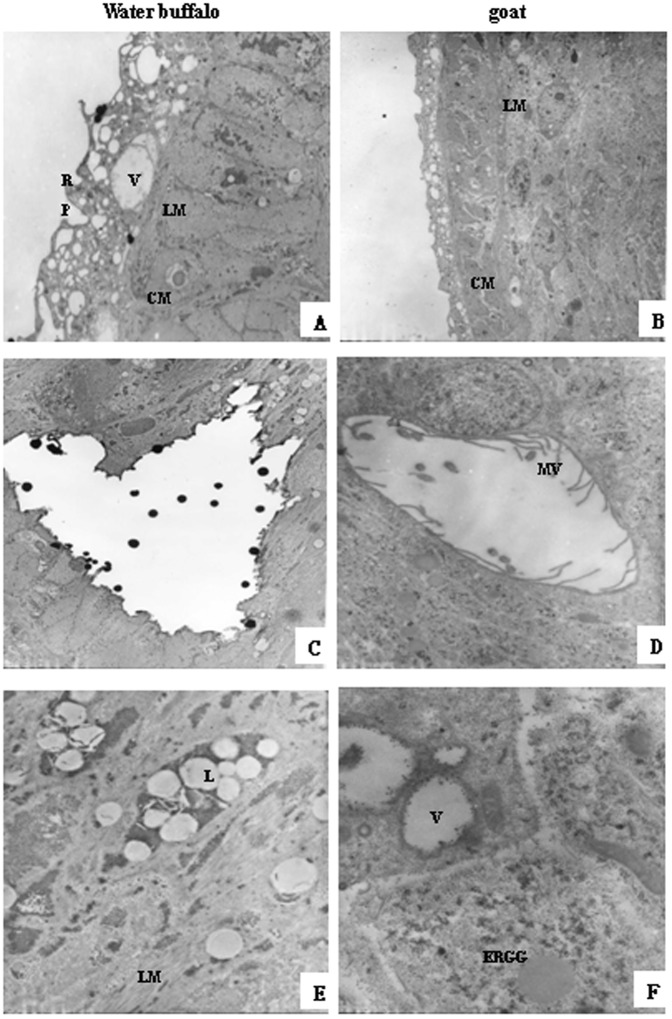
Comparisons of male worms derived from water buffalo and goats by transmission electron microscopy (TEM).(A, B) tegument, 2,000× magnification; (C–F) subtegument and inner structures; (C, D) 3,000× magnification; (E, F) 10,000× magnification. R, ridge; P, pore; V, vacuoles; LM, longitudinal muscle; CM, outer circular muscle; MV, microvilli; L, lipid droplet; ERGG, endoplasmic reticulum glycogen granule.